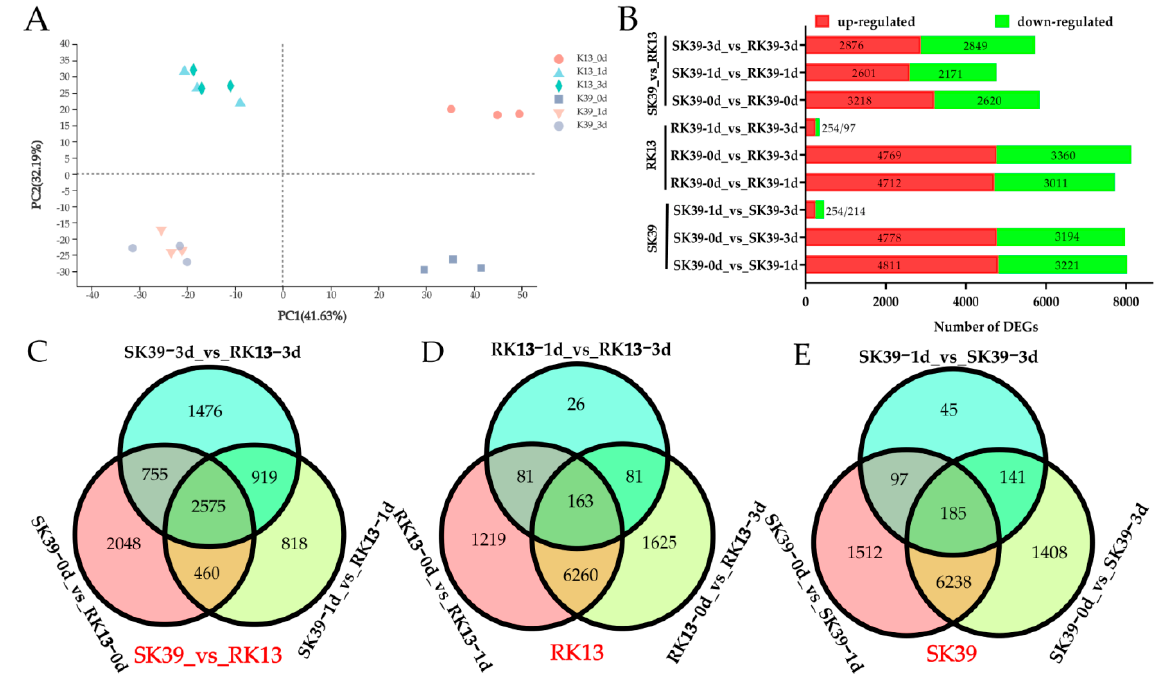
Figure 2. Comparative analysis of differentially expressed genes (DEGs) in the sweet corn response to southern corn leaf blight. ( A ) Principal component analysis of the transcriptome data in RK13 and SK39 treated with the C. heterostrophus . ( B ) The numbers of up- and down-regulated DEGs in the different comparison groups. ( C ) Venn diagram of DEGs in the SK39_vs_RK13 group (includes three pairwise combinations, SK39 − 0d_vs_RK13 − 0d, SK39 − 1d_vs_RK13 − 1d, and SK39 − 3d_vs_RK13 − 3d). ( D ) Venn diagram of DEGs in the RK13 group (includes three pairwise combinations, RK13 − 0d_vs_RK13 − 1d, RK13 − 1d_vs_RK13 − 3d and RK13 − 1d_vs_RK13 − 3d). ( E ) Venn diagram of DEGs in the SK13 group (includes three pairwise combinations, SK39 − 0d_vs_SK39 − 1d, SK39 − 1d_vs_SK39 − 3d and SK39 − 1d_vs_SK39 − 3d). Red labels represent group names.